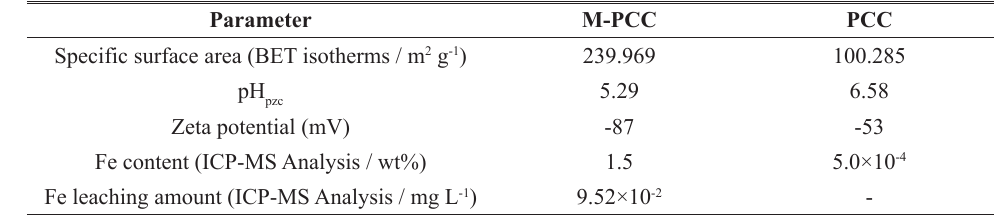
Table 1: S urface characteristics and the amounts of Fe impregnated and leaching to water from M-PCC and PCC.